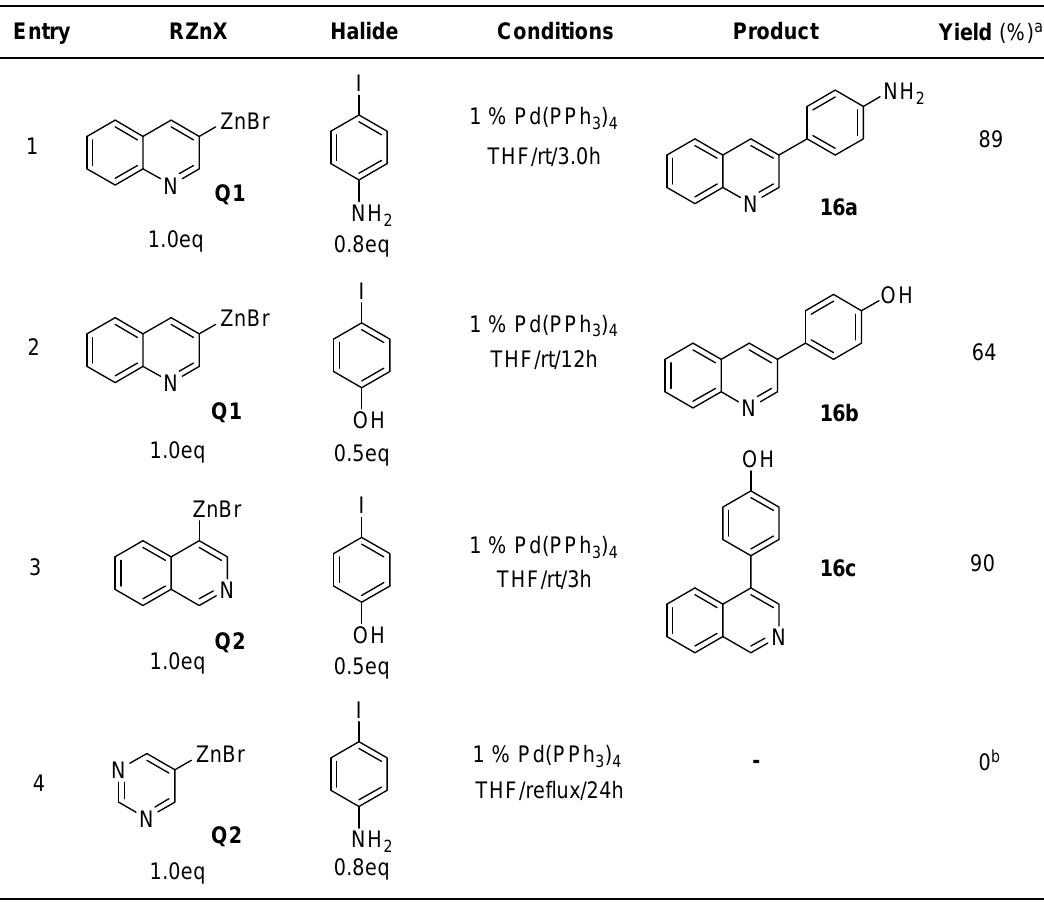
Table 16. Preparation of quinoline and isoquinoline